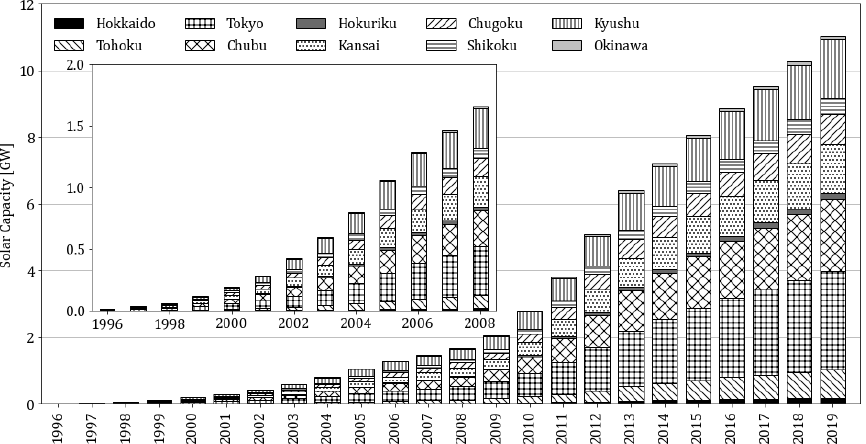
Figure 4. Development of residential ( < 10 kW) solar PV capacity (GW) in Japan from 1996 to 2019 by electricity power companies’ regional service